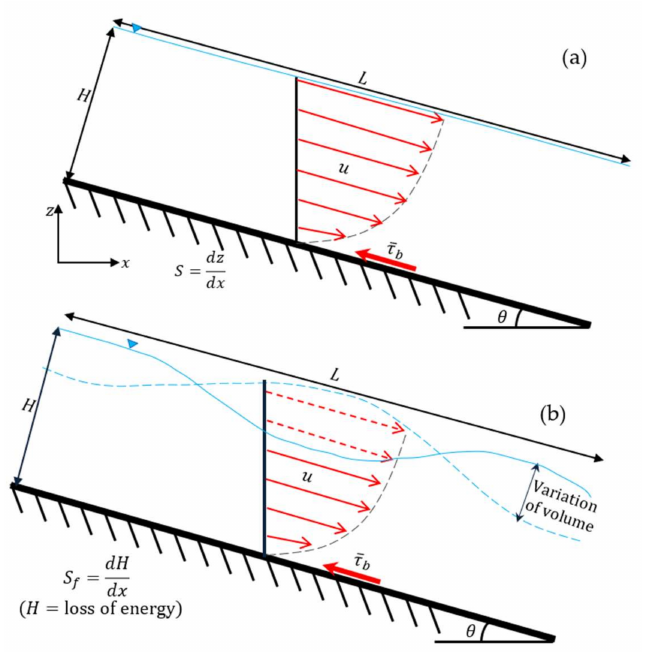
Figure 5. Schema of ( a ) uniform and ( b ) non-uniform flow (modified from Graf and Altinakar